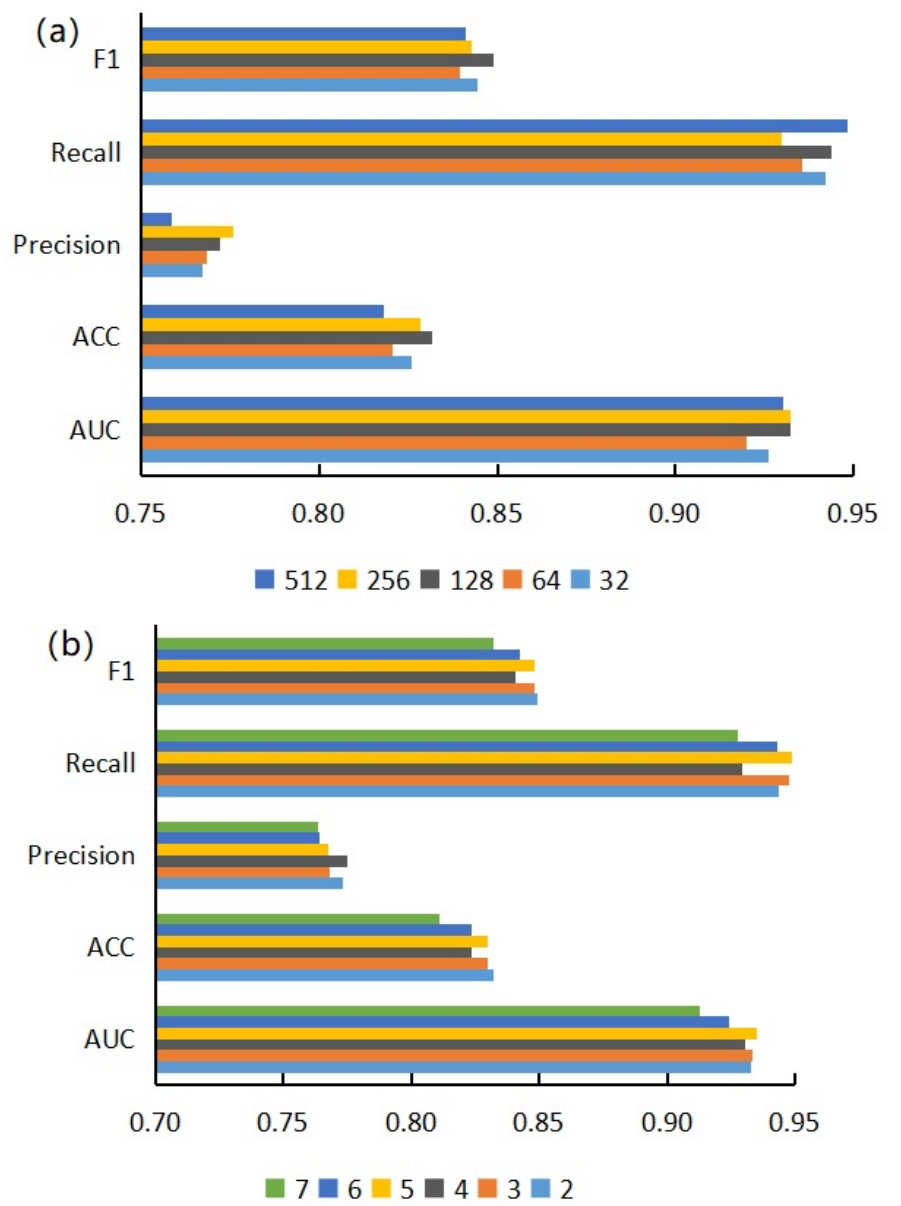
Figure 5. ( a ) Effects of different projection dimensions on model performance; ( b ) influence of different encoder layers on model performance.